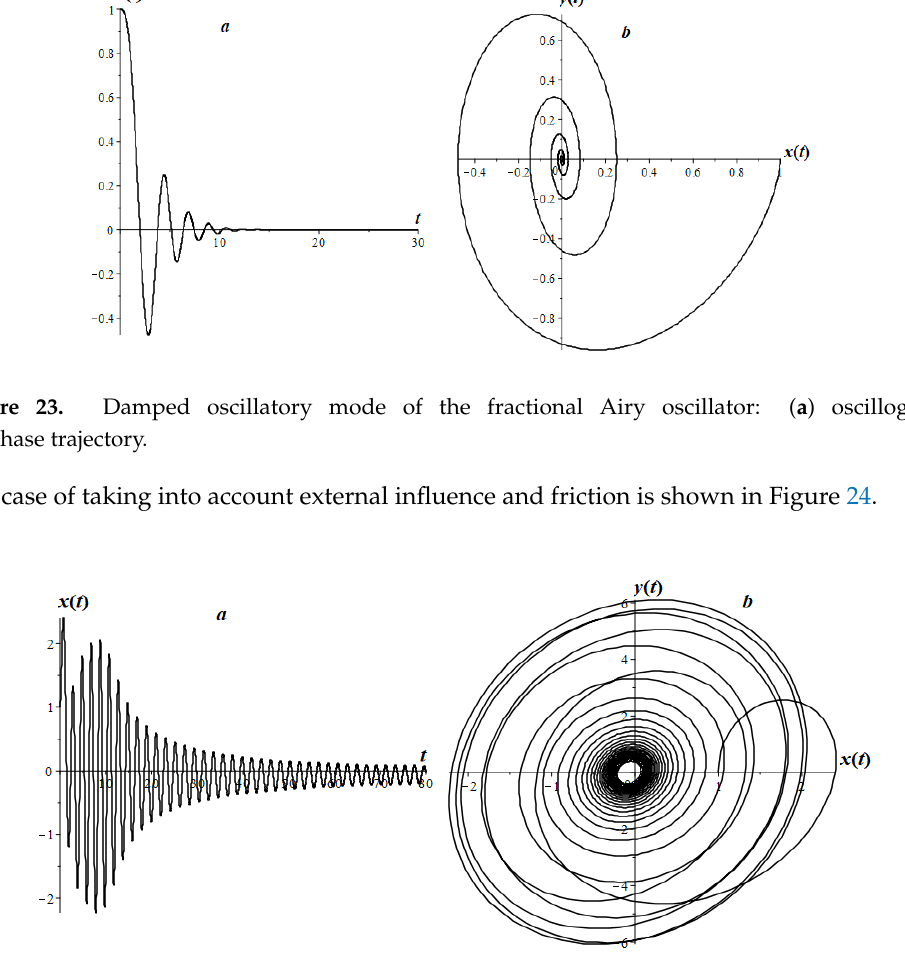
Figure 24. Fractional Airy oscillator with friction and external action: ( a ) oscillogram; ( b ) phase